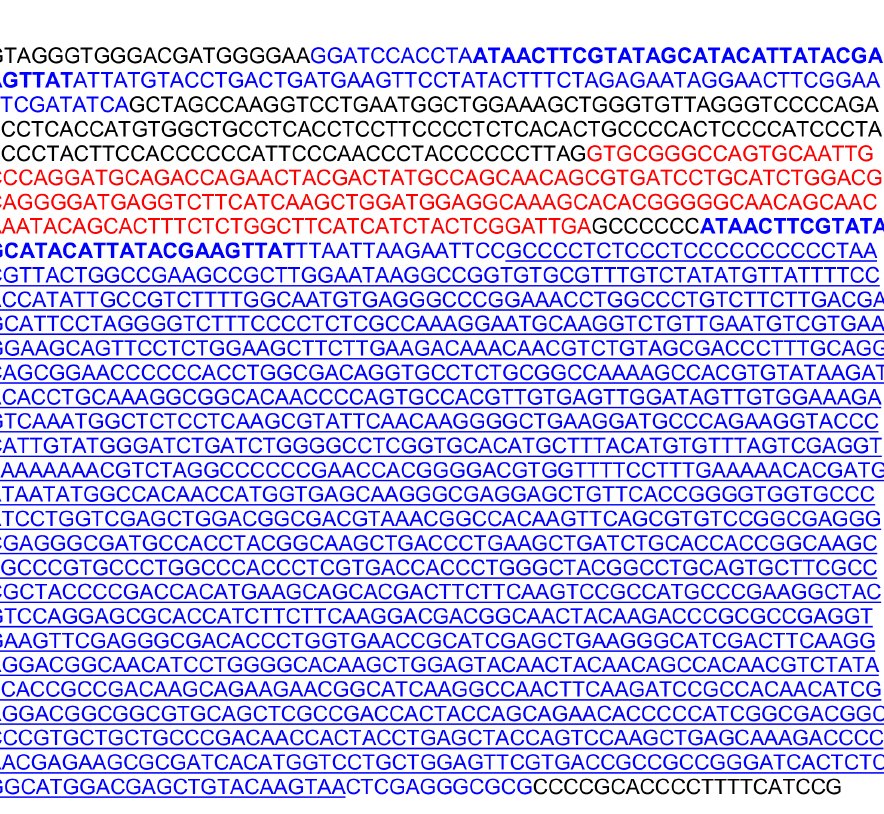
Fig 1. Sequence of C1ql1 conditional mutant allele. Sequence of the novel C1ql1 allele, (after the neomycin resistance cassette was removed) beginning partway through the intron. In black is the original non-coding C1ql1 allele, in red is the open reading frame (ORF) for exon 2, in blue are bases added to the allele with loxP sites bolded and IRES-mVenus